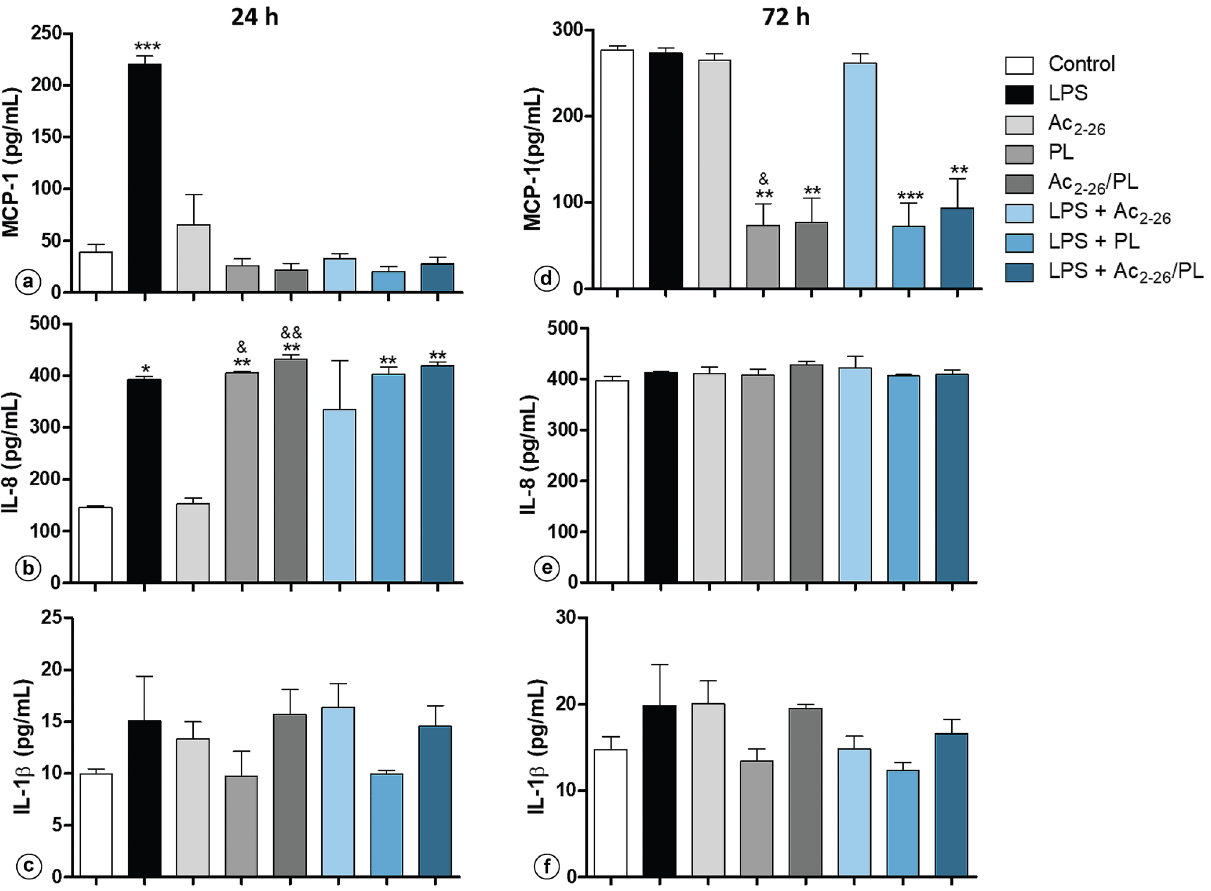
Figure 6. PL modulates chemokine and cytokine expression. ELISA analysis of proinflammatory cytokines MCP-1 ( a , d ), IL-8 ( b , e ), and IL-1β ( c , f ) from culture supernatants of HUVECs treated with LPS, Ac 2-26 and/ or PL for 24 and 72 h. No LPS/PL/Ac 2-26 was added to the negative control. Results represent the mean ± SEM from of three independent assays (n = 3). * p < 0.05, ** p < 0.01, and *** p < 0.001 versus untreated control; & p < 0.05, && p < 0.05 versus Ac 96 2-26 . Reproduced with permission from